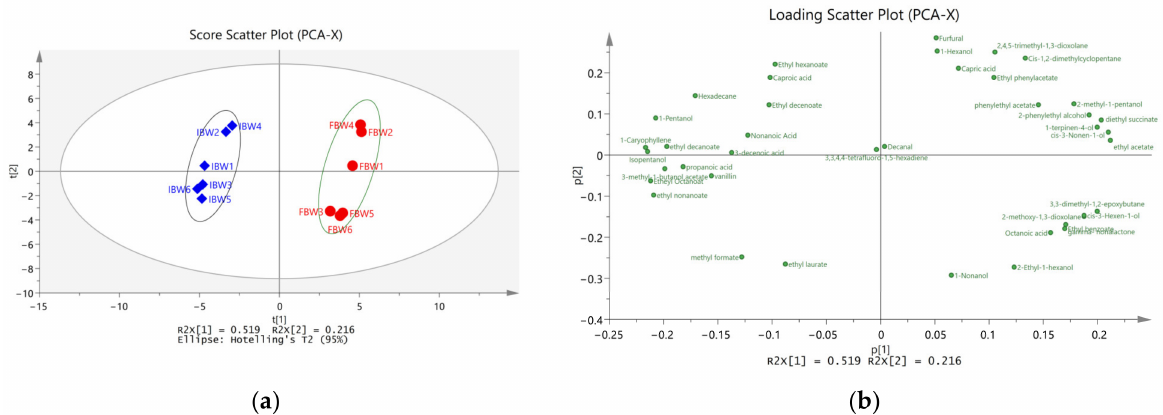
Figure 1. The PCA score plot and loading plot of volatile compounds: ( a ) Scores scatter plot t1 vs. t2; t[1] and t[2] represent PC1 and PC2. ( b ) Loadings scatter plot p1 vs. p2.